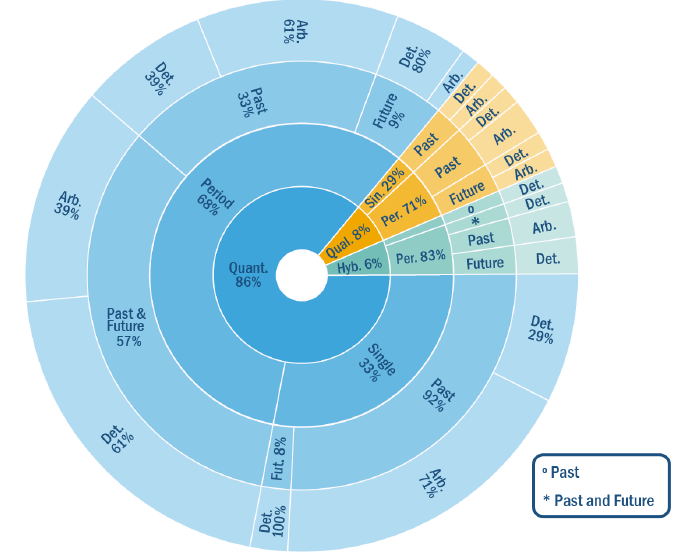
Figure 7. Summary of type of research, temporal extension, temporal position, and temporal motiva- tion of the 96